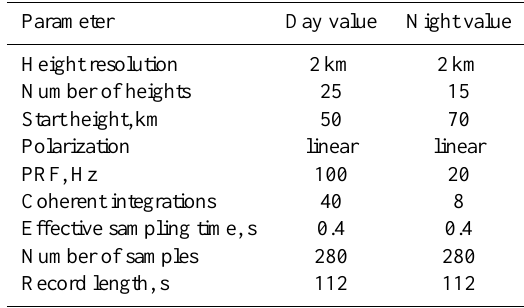
Table 1. Experimental parameters used for routine spaced antenna (SA). Analysis for the Buckland Park MF